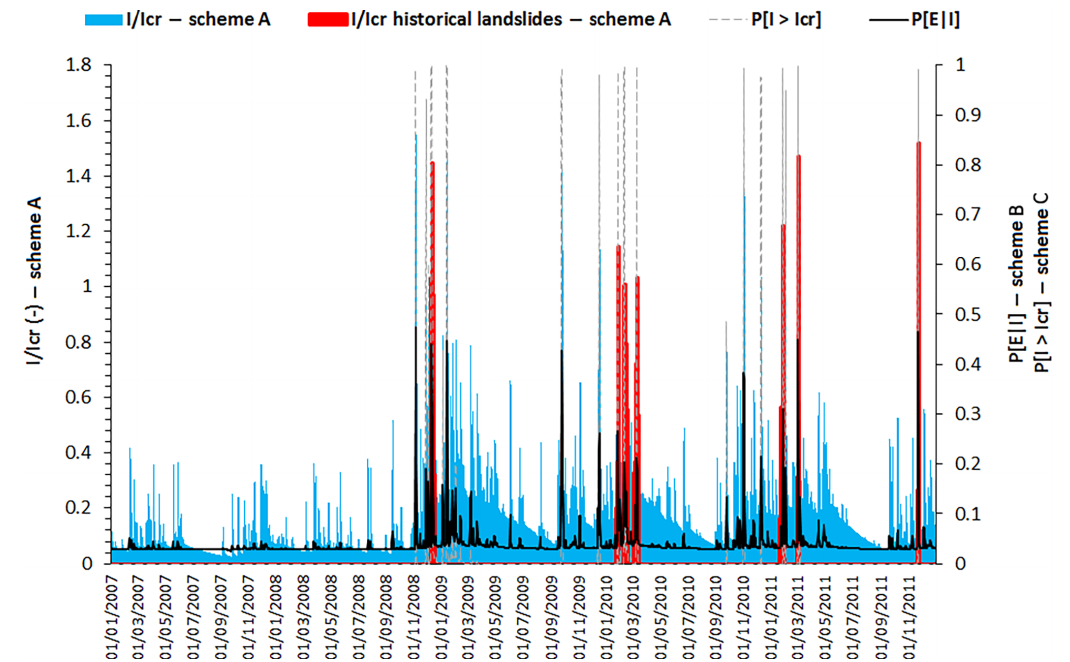
Figure 3. Application of FLaIR model – temporal behavior of I/I cr (Scheme A), P [ E | I ] (Scheme B) and P [ I > I cr ] (Scheme C) in 2007– 2011 for Gimigliano municipality (southern Italy).